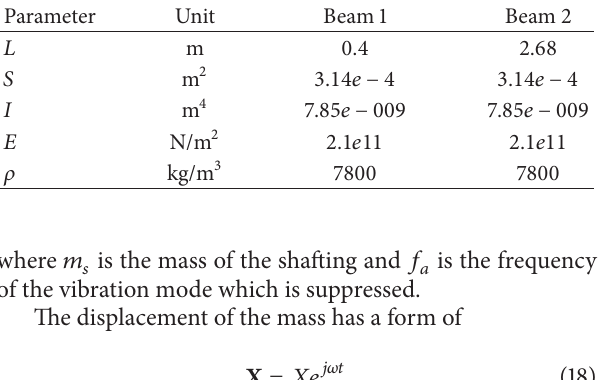
Table 6: Parameters of propulsion shafting.